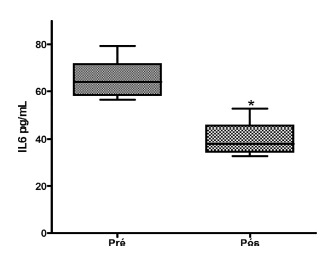
Evaluation of the plasma IL-6 quantification of pre and post-DSP (p <0.5)